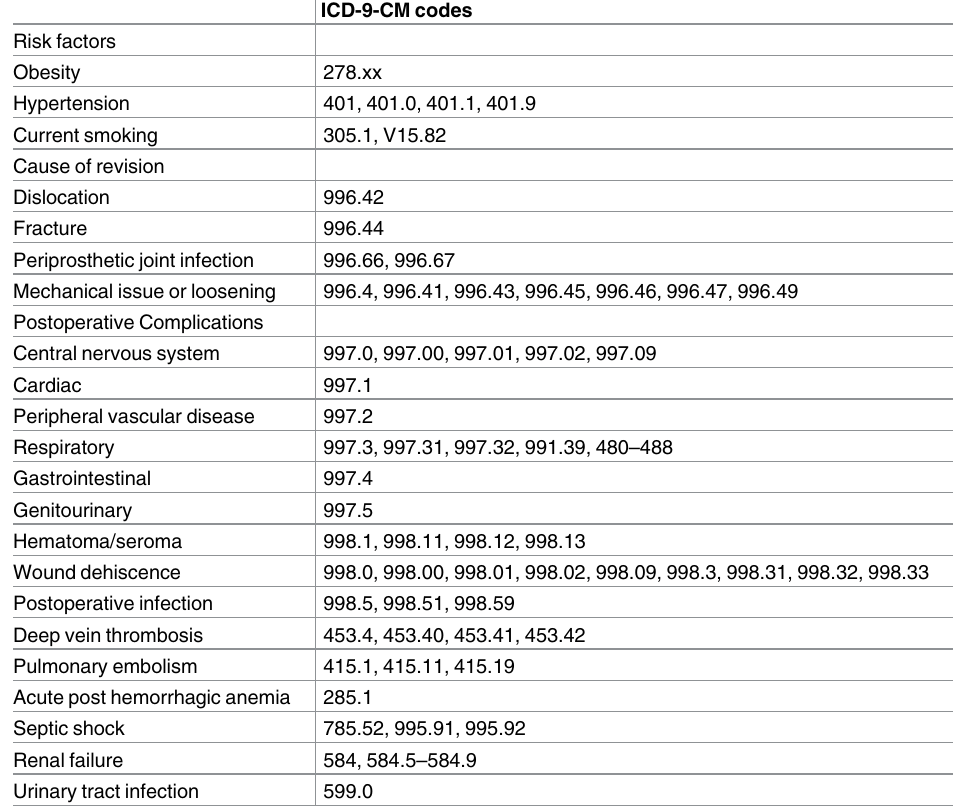
Table 1. Risk factors, causesfor revision and in-hospital postoperative complications with corre- sponding ICD-9-CM